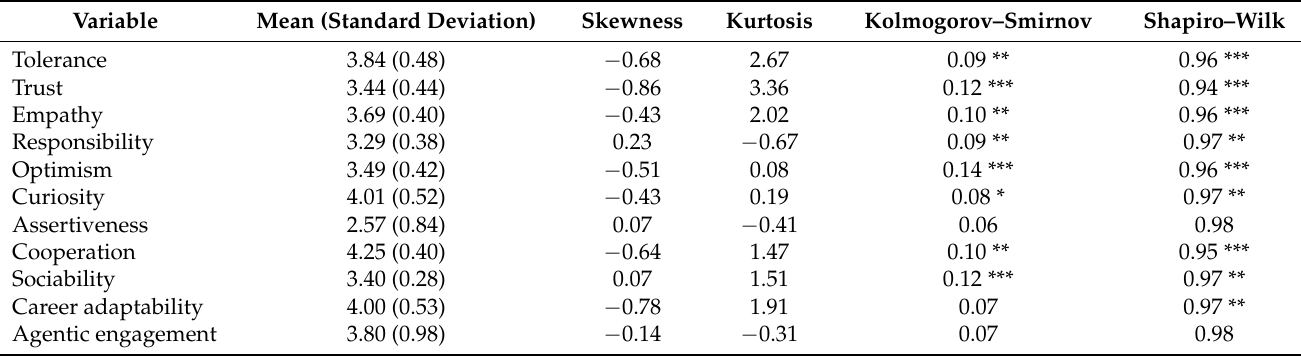
Table 1. Descriptive statistics results.